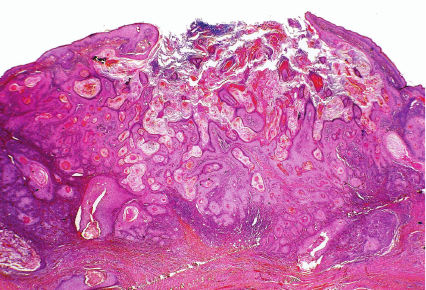
Figure 15: Keratoacanthoma: low power magnification showing a crateriform lesion which is filled with central keratinous plug and bounded by proliferative lesional squamous epithelium. (H&E, × 20).